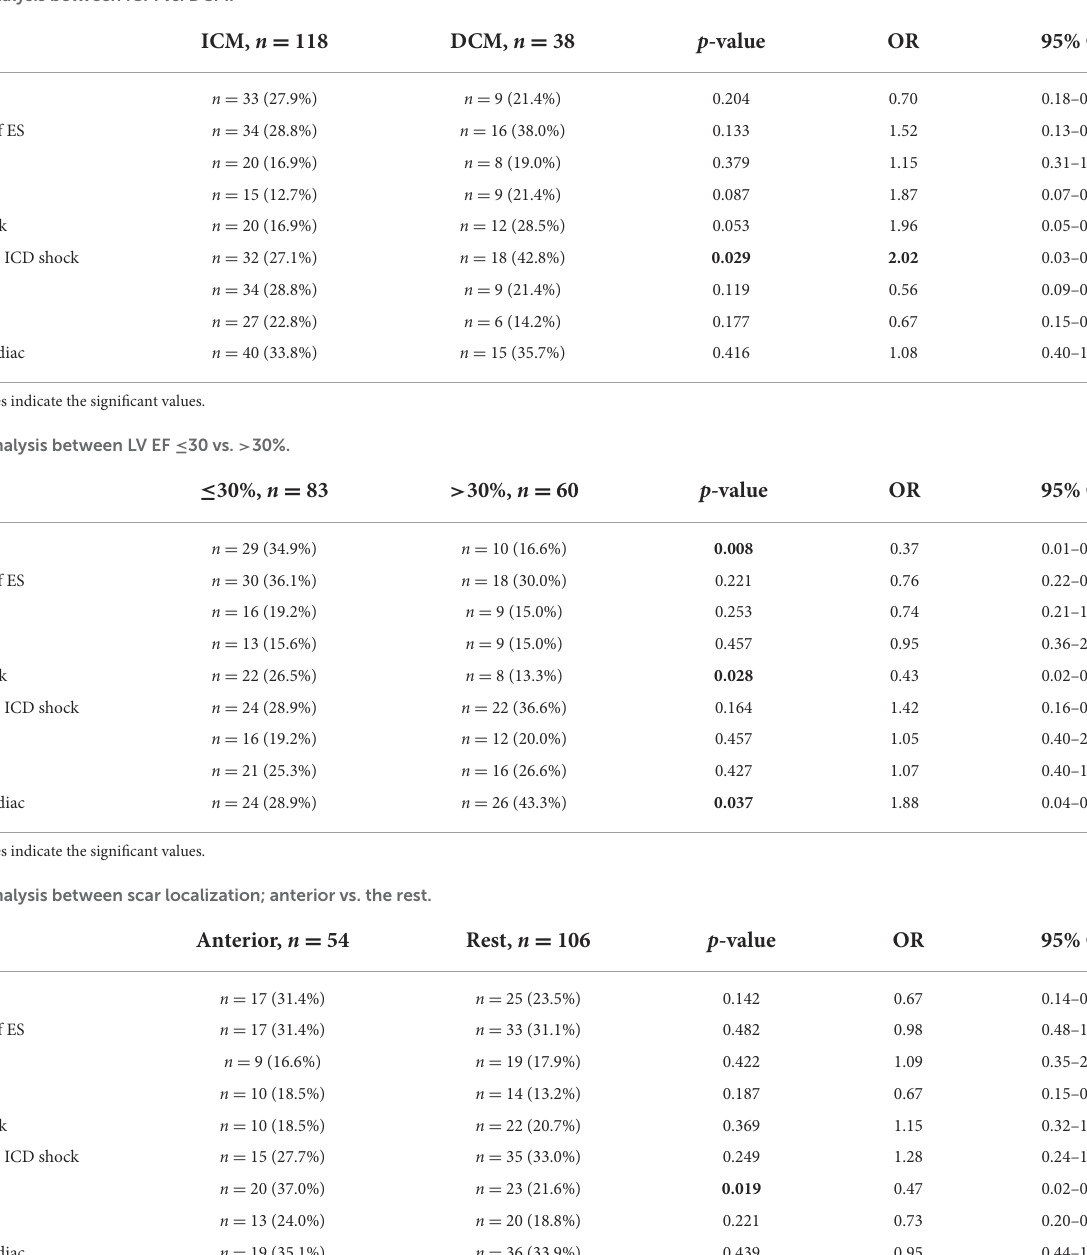
TABLE 4 analysis between ICM vs. DCM.